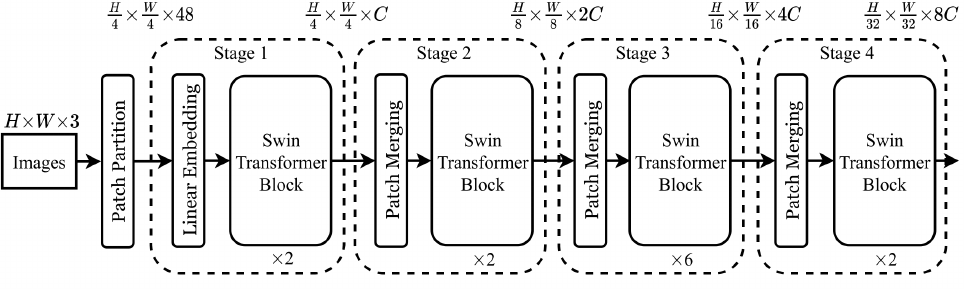
Figure 4. Swin tiny transformer architecture